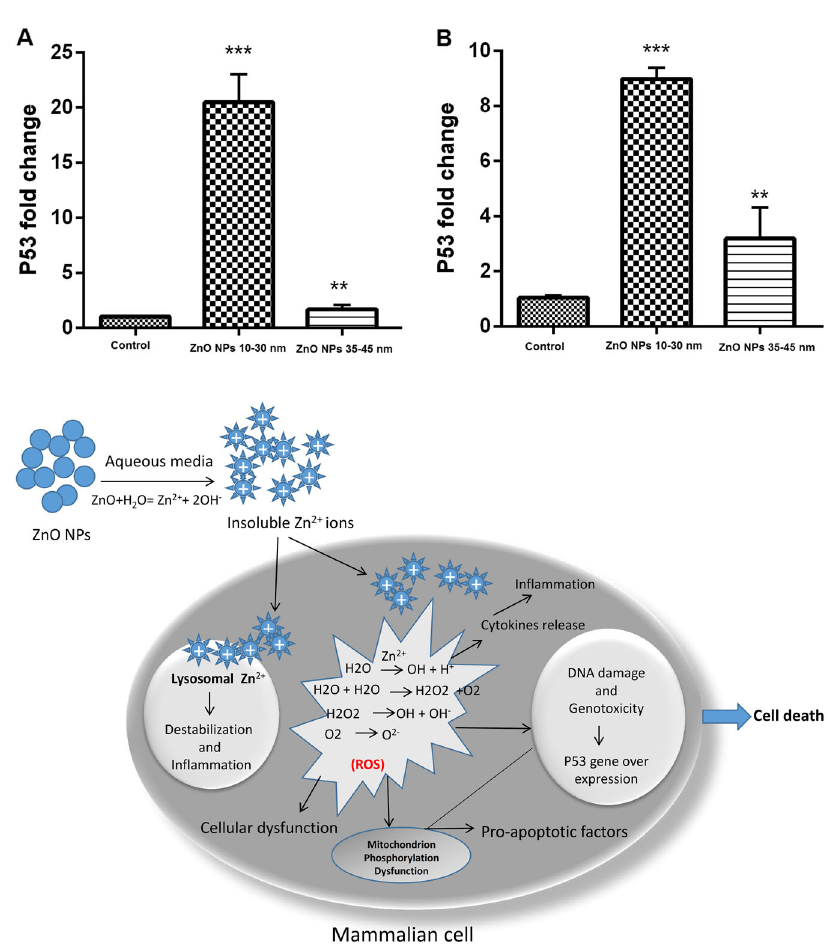
Fig. 7 Relative gene expression of NF-kB gene in the cells treated with ~10 – 30 and 35 – 45 of ZnO NPs in comparison to the control groups. The expression level of the NF-kB gene in both AMSCs ( A ) and